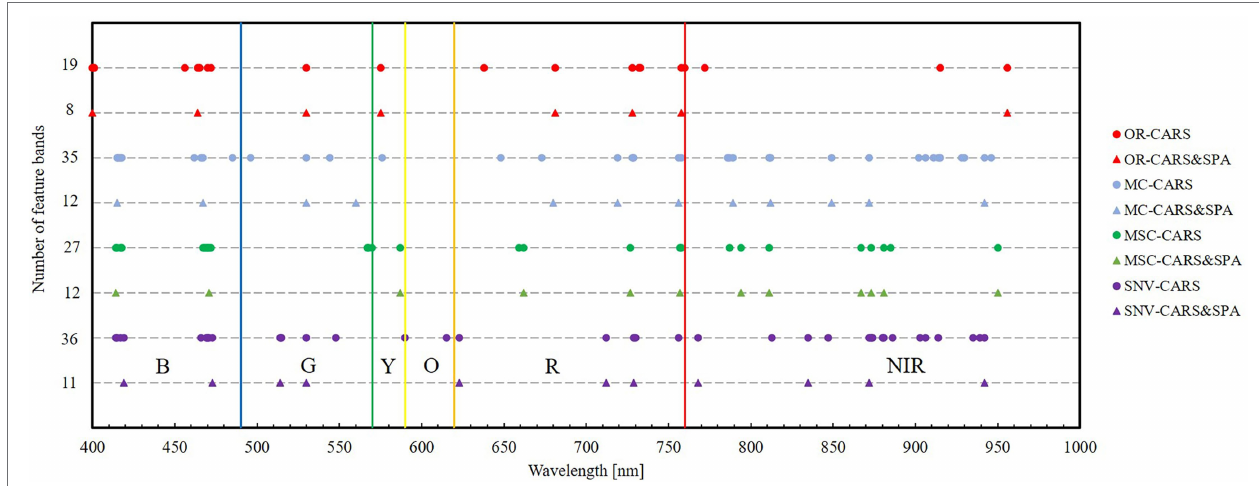
FIGURE 6 | Location and number of feature bands selected by the eight